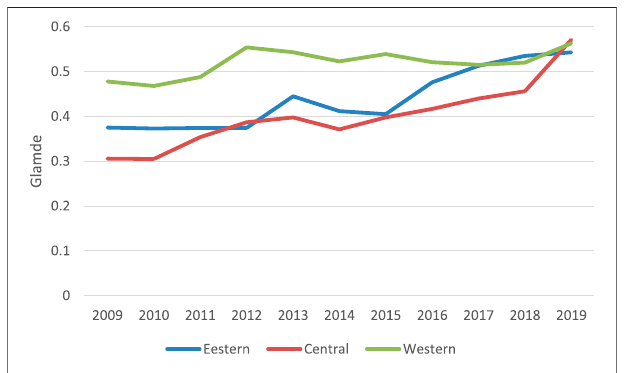
FIGURE 3 | The geometric mean of Glande by